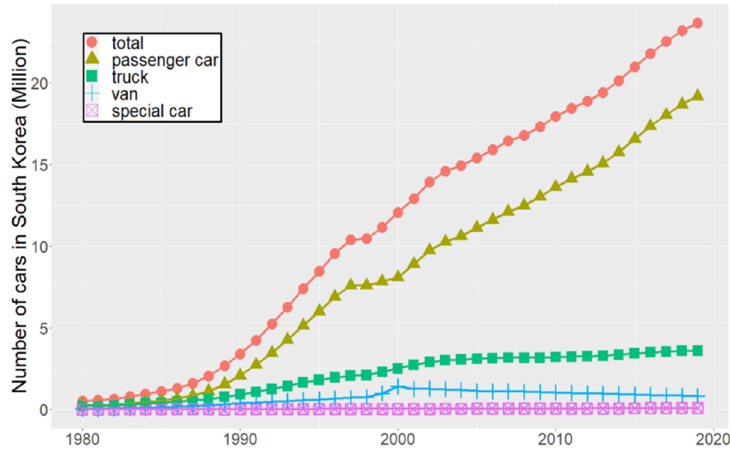
Figure 1. Number of cars in South Korea.